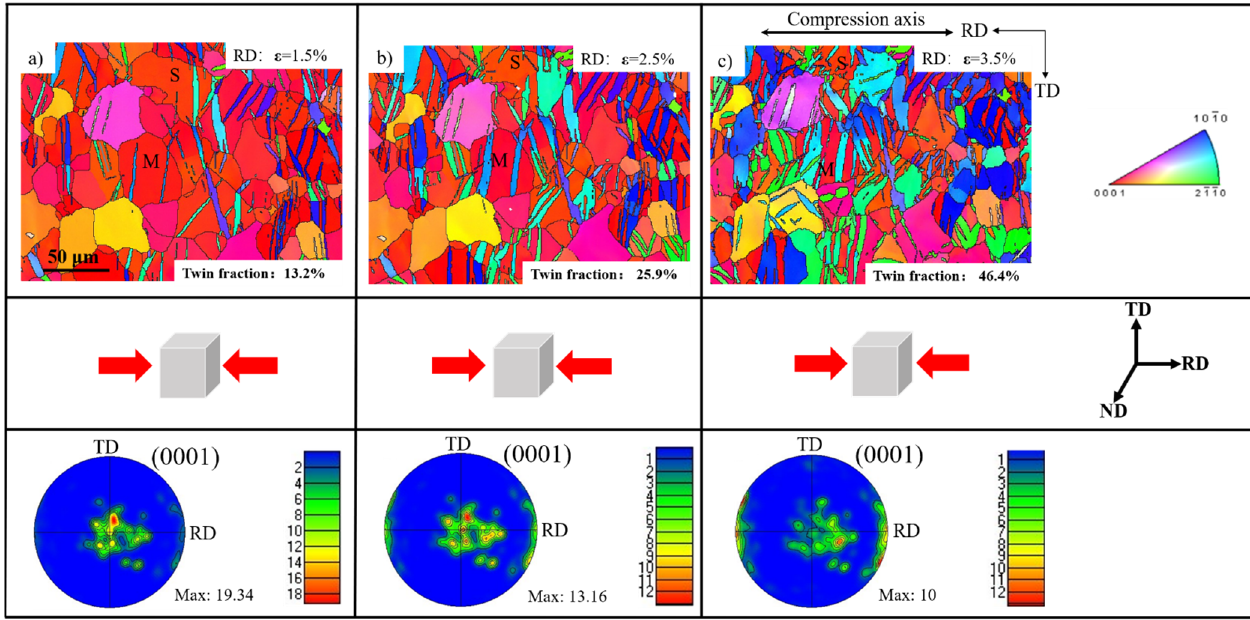
Figure 4. In situ EBSD figures and their corresponding pole figures at different strain levels: ( a ) 1.5%, ( b ) 2.5%, ( c ) 3.5%.